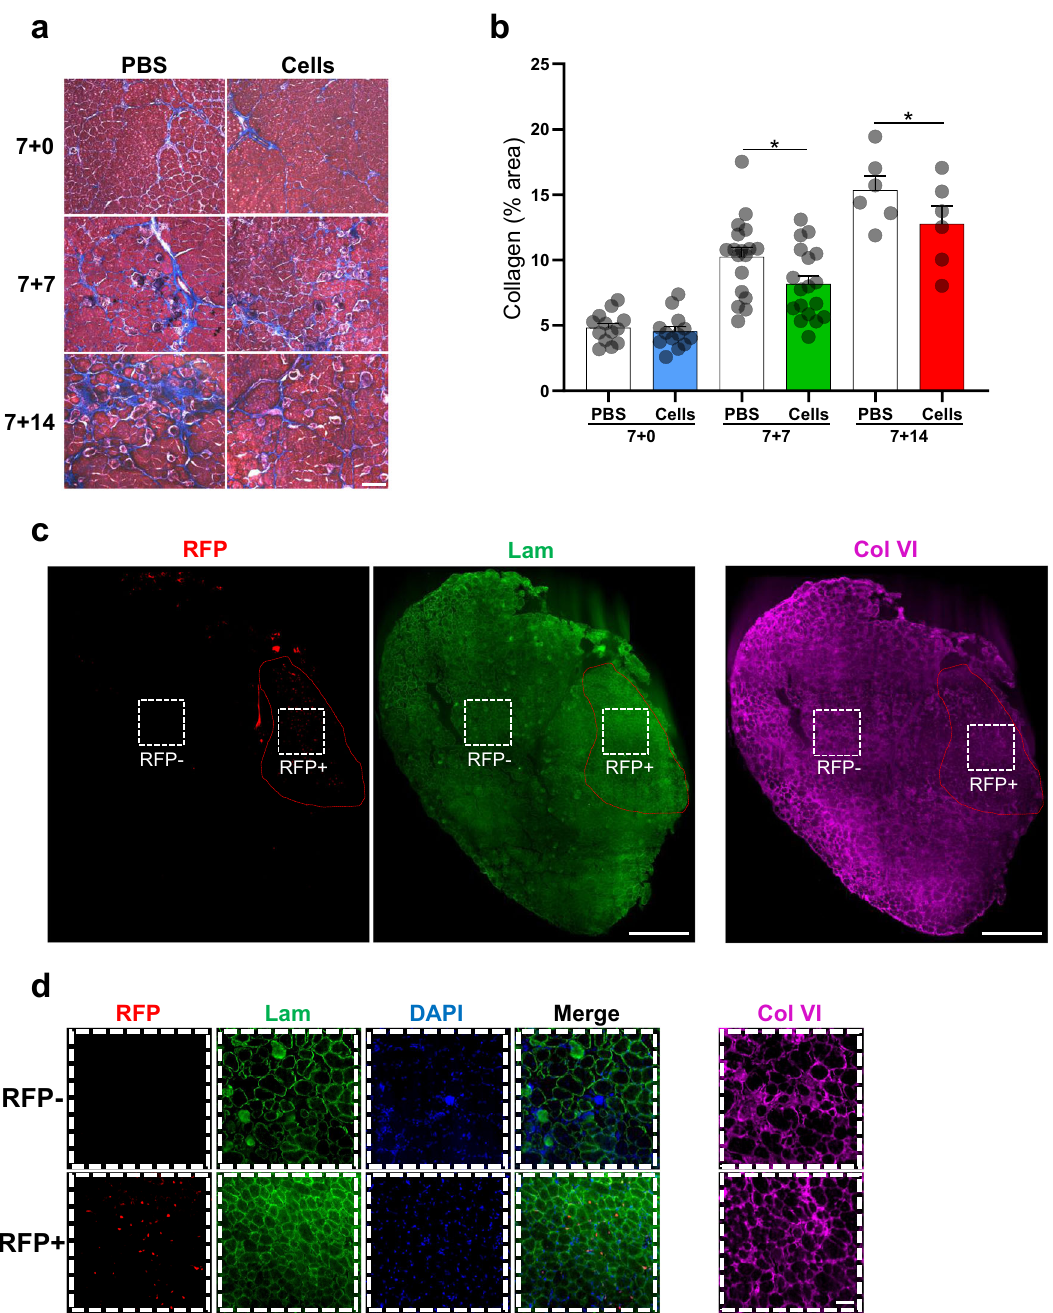
Fig. 4 Transplantation of myogenic progenitors counteracts the fi brosis induced by DUX4 expression in iDUX4pA-HSA mice. a Representative images show Masson ’ s trichrome staining for the 3 experimental cohorts of iDUX4pA-HSA mice: 7 + 0, 7 + 7, and 7 + 14. Right panels show transplanted TA muscles, while left panels display respective contralateral PBS controls. Scale bar is 100 µm. b Quanti fi cation of the percentage of collagen staining in the total muscle section. Data are shown as mean ± SEM ( n = 13 for 7 + 0, n = 18 for 7 + 7 and n = 6 for 7 + 14). * p < 0.05 by the Student ’ s t test. c Representative images of a whole muscle section show immunostaining for RFP (in red), Lam (in green), and Col VI (in purple; staining performed on the consecutive slide) in transplanted TA muscle from iDUX4pA-HSA mice (7 + 14). Engrafted area has been highlighted in red to denote the engraftment location on the Col VI staining. DAPI in blue. Scale bar is 500 µm. d Images show higher magni fi cation of negative and positive RFP areas from c (from white dashed lines used to depict RFP- and RFP + areas). Scale bar is 50